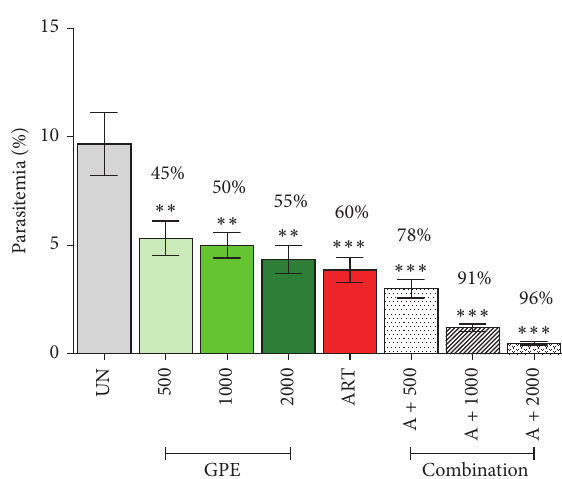
Figure 2: Antimalarial activity of Moringa oleifera . Groups of na¨ıve ICR mice (5 mice each) were infected intraperitoneally with 1 × 10 7 parasitized erythrocytes of PbANKA. They were then given orally the extract (500, 1,000, and 2,000 mg/kg) either alone or in combi- nation with artesunate (6 mg/kg) for 4 consecutive days. Untreated and artesunate treated mice were used as negative and positive controls, respectively. Parasitemia and suppression percentage were subsequently measured. ∗ 𝑃 < 0.05 , ∗∗ 𝑃 < 0.01 , and ∗∗∗ 𝑃 < 0.001 , compared to untreated control. UN: untreated control; MOE: M. oleifera extract; ART: 6 mg/kg of artesunate; A + 500: combination of 6mg/kg of artesunate and 500 mg/kg of MOE; A + 1000: combination of 6mg/kg of artesunate and 1000 mg/kg of MOE; A + 2000: combination of 6 mg/kg of artesunate and 2000 mg/kg of MOE. The results came from 3 independent